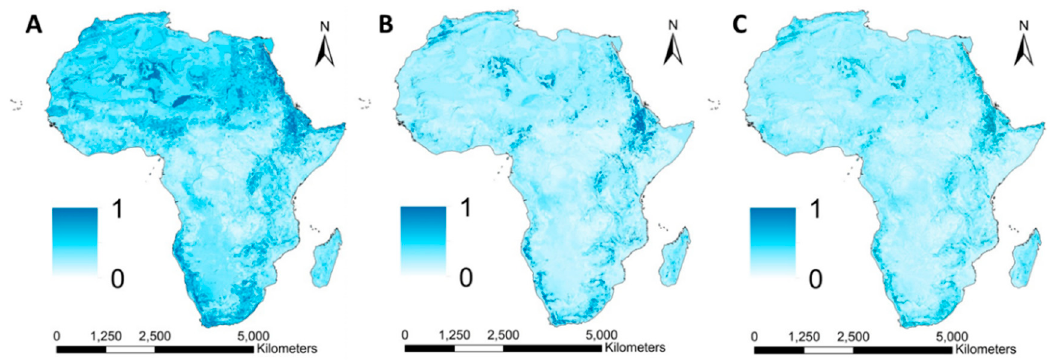
Figure 4. Geospatial variation of the processes associated with surface runoff generation (A), transportation (B) and accumulation (C) assessed by the Intense Pluvial Runoff (IRIP) method (65).